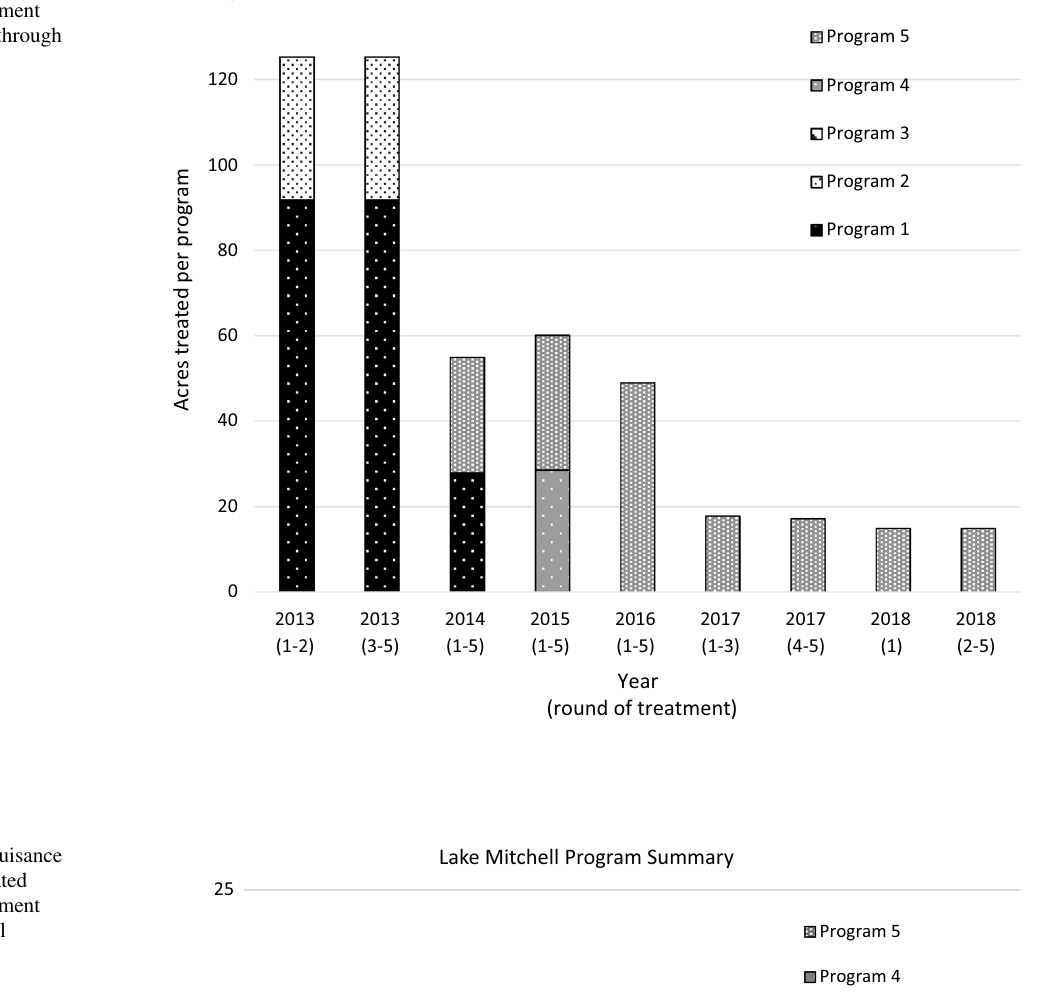
Fig. 3 Surface acres of nuisance L. wollei infestations treated with each algaecide treatment program in Jordan Lake through time